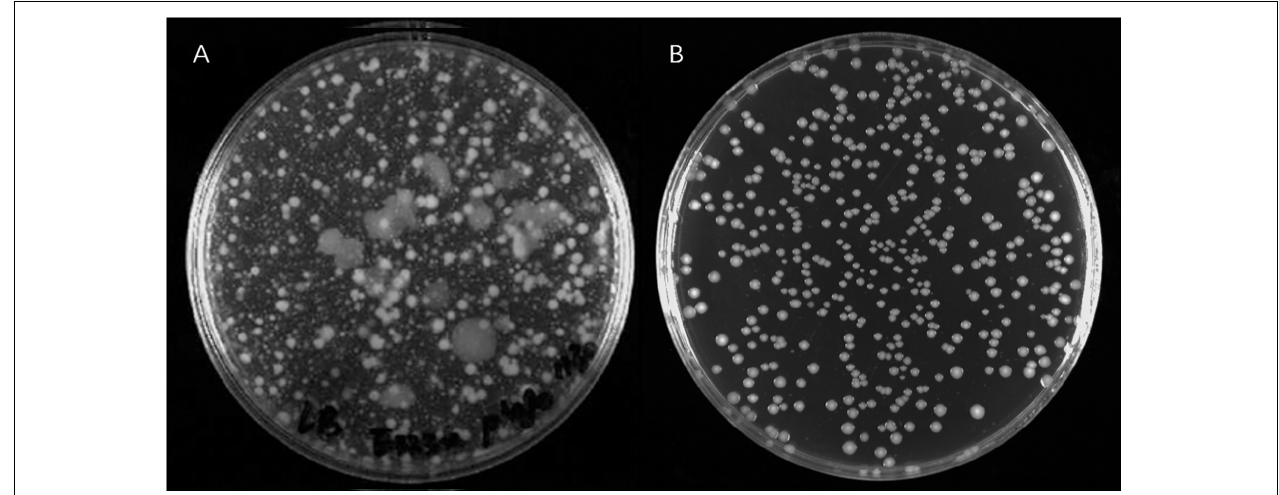
FIGURE 1 | The phage resistant colonies derived from V. alginolyticus E06333 and normal colonies V. alginolyticus E06333. (A) The phage resistant colonies occurred on a double-layer plate with enriched lytic phages. (B) The normal colonies of V. alginolyticus E06333 on a LB plate.